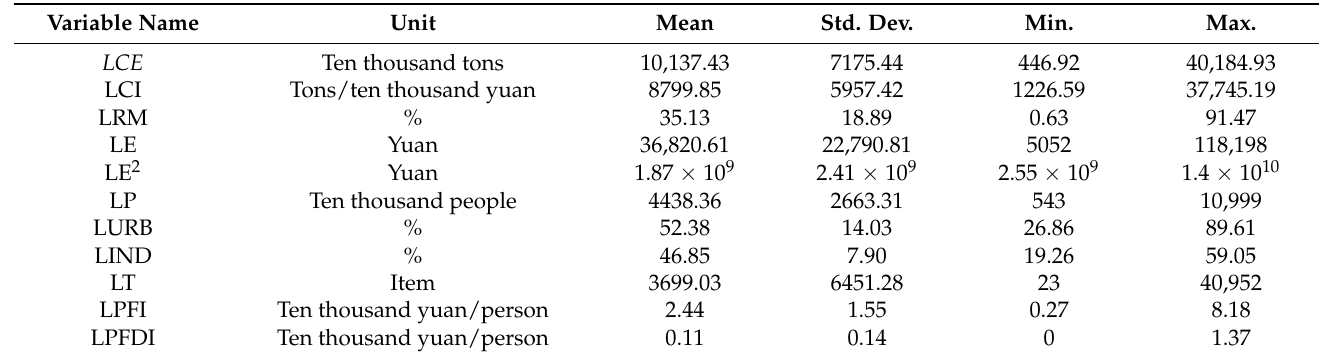
Table 3. Descriptive statistics of each variable.